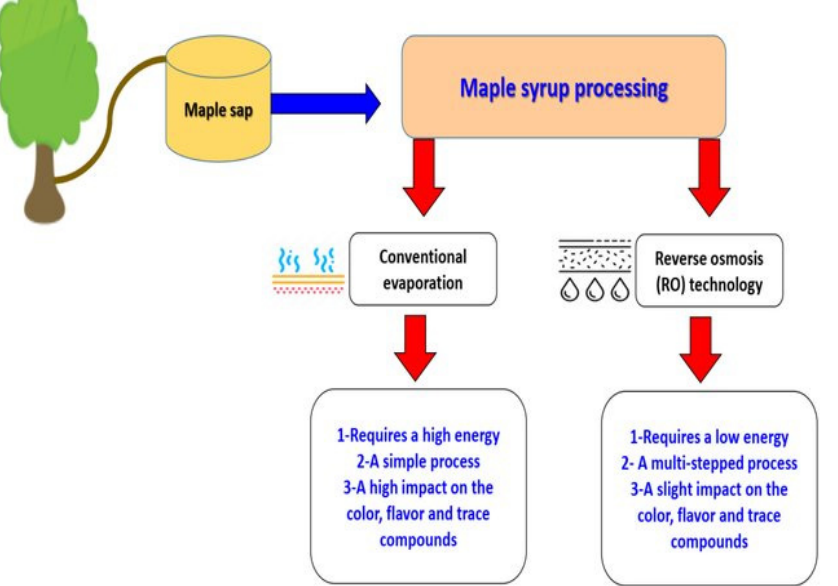
Figure 2. A comparison of the two processing methods to produce maple syrup (Adapted from Ramadan et al. [56]).